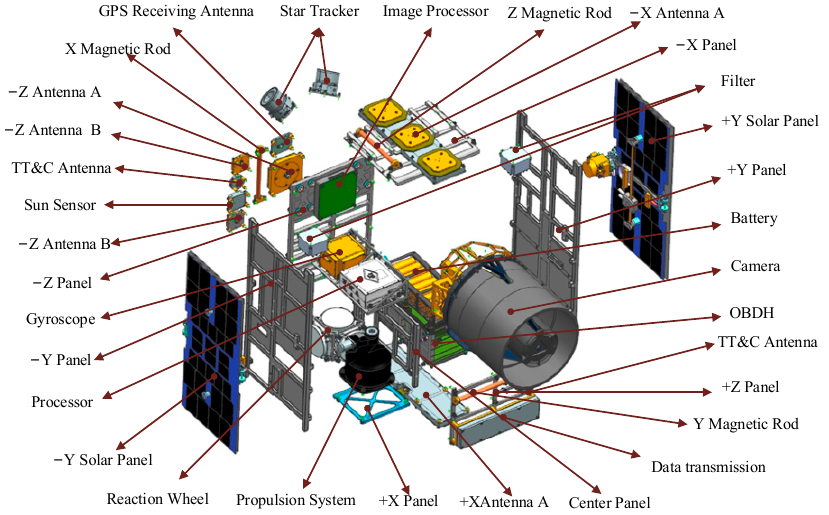
Figure 2. Exploded view of the MF satellite.